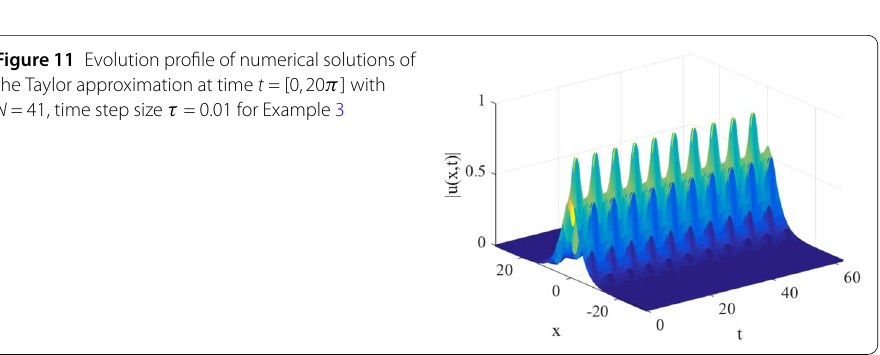
Figure 11 Evolution profile of numerical solutions of the Taylor approximation at time t = [0,20 π ] with N = 41, time step size τ = 0.01 for Example